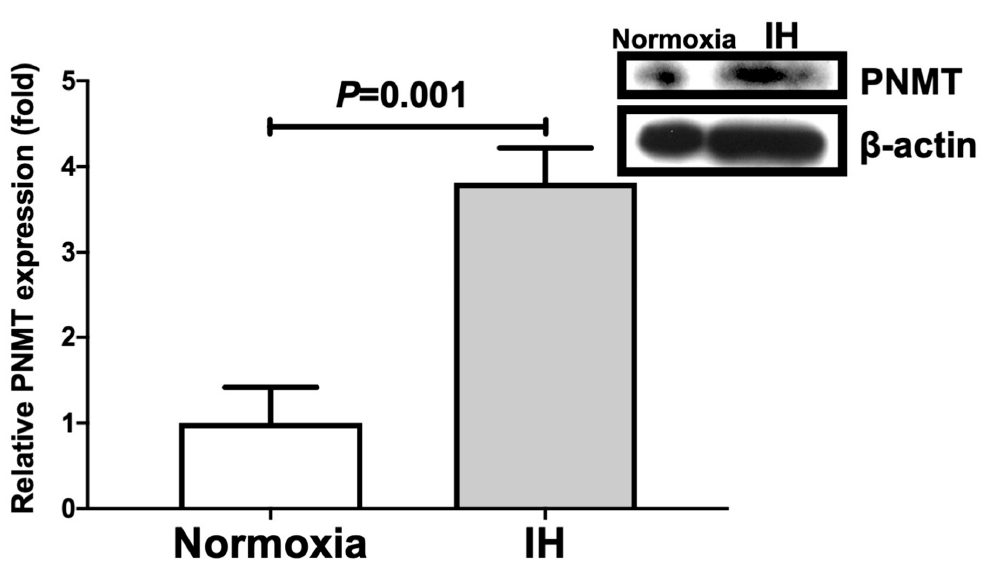
Figure 4. Relative protein expression of PNMT in human NB-1 neuroblastoma cells subjected to IH. A representative immunoblot is shown in the right panel. The relative expression of PNMT is arbi- trarily presented. The PNMT band densities were quantified using an image analysis and then nor- malized to β -actin, as measured in the same blot. Each bar represents the mean values of six inde- pendent experiments. The results are expressed as the mean ± SE in arbitrary units.